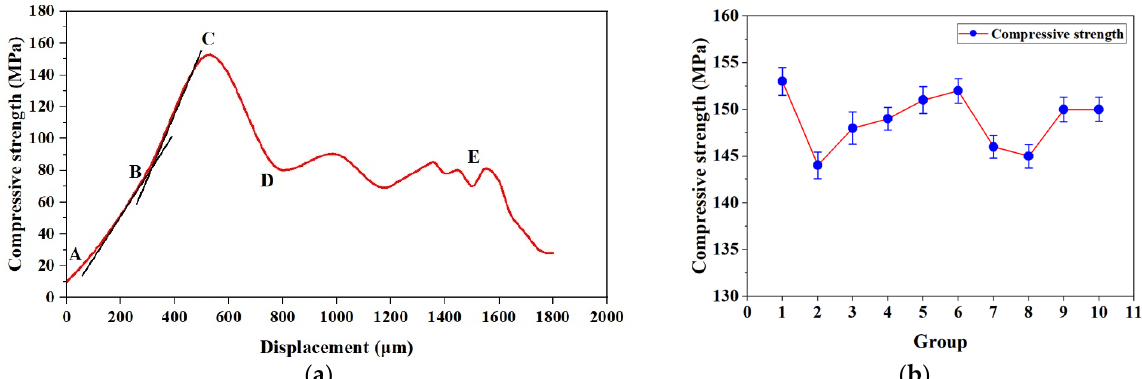
Figure 8. Test fi ndings for the compressive strength of plugging agents: ( a ) the compressive Figure 8. Test findings for the compressive strength of plugging agents: ( a ) the compressive strength strength displacement variant; ( b ) each group’s greatest compressive strength. displacement variant; ( b ) each group’s greatest compressive strength.